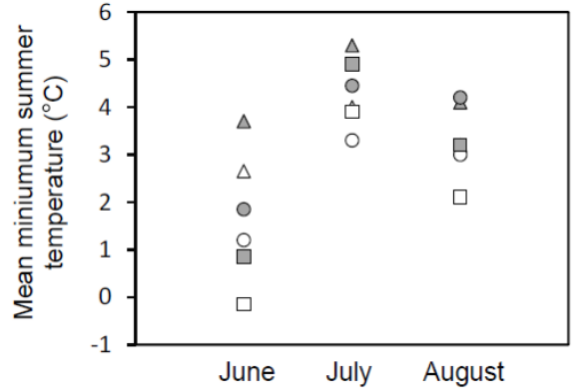
Figure 1. Seasonal and inter-annual variation in mean minimum summer temperatures for Mount Evans (open symbols) and Niwot Ridge (filled symbols) as estimated by PRISM interpolation (Daly et al. 2008). Symbol shape denotes year (2012: triangles, 2013: circles, and 2014: squares). Tongue length phenotype did not vary within or among years (M-S15, Fig. S4) despite significant variation in temperature.